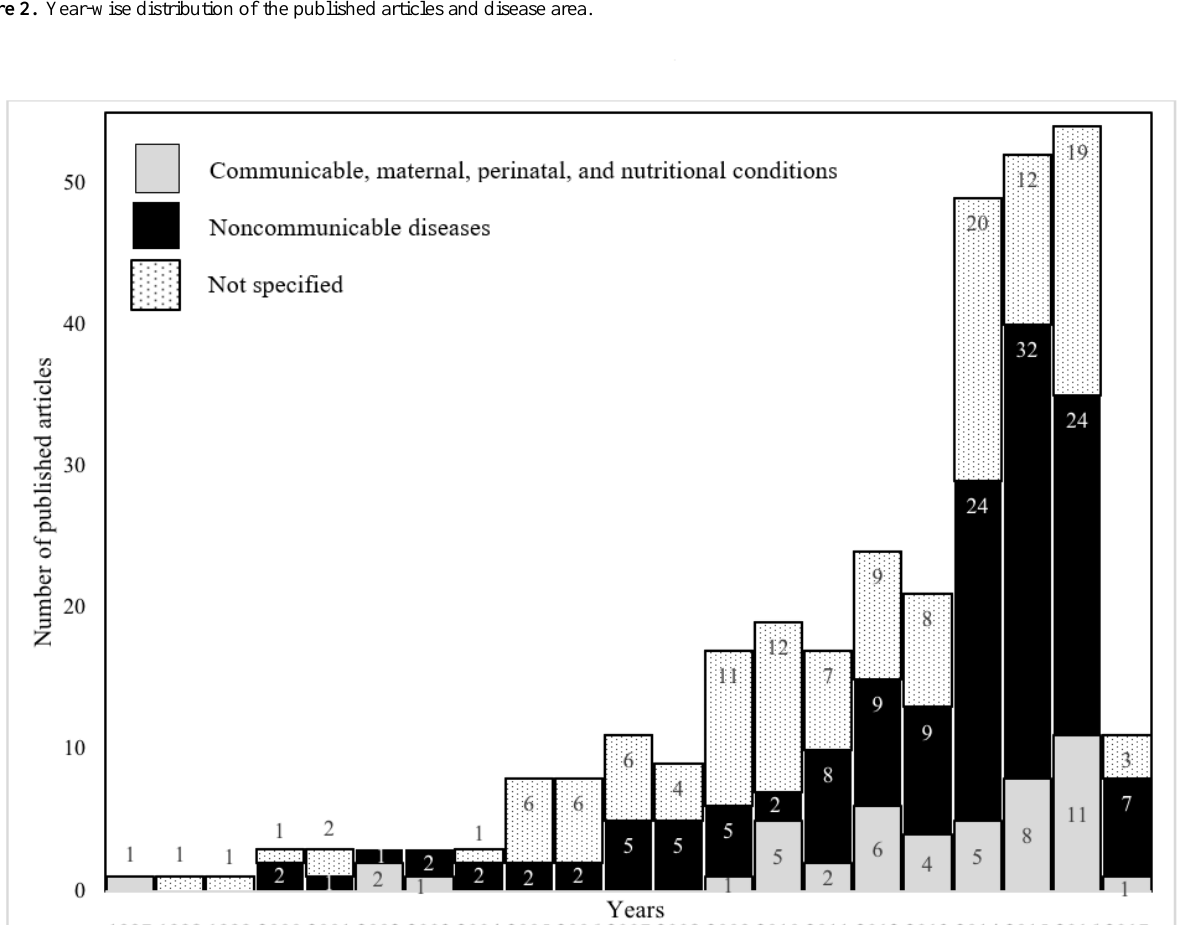
Figure 2. Year-wise distribution of the published articles and disease area.